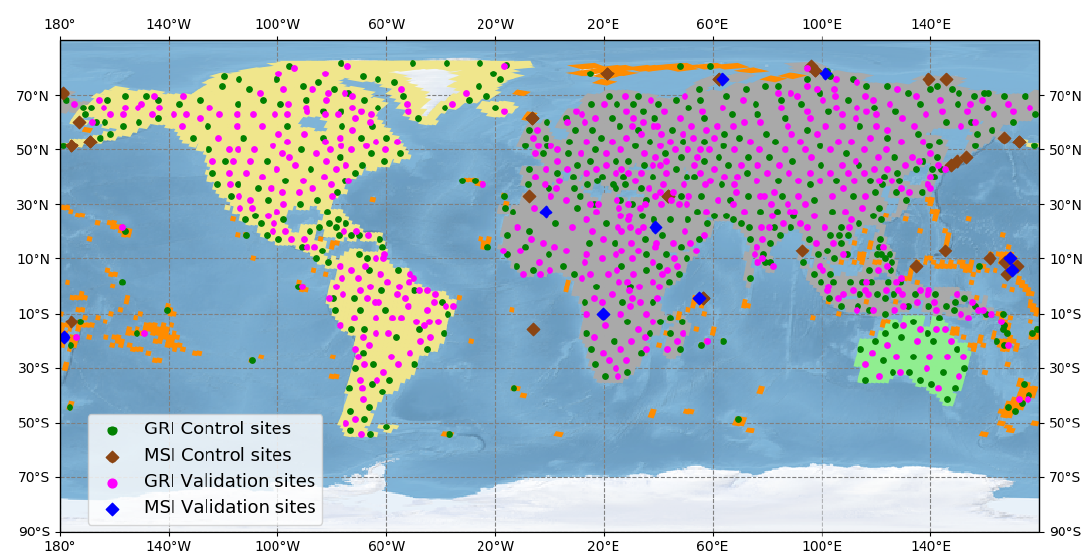
Figure 2. Control and Validation sites used in the block triangulation procedure. The green and magenta circles represent the Global Reference Image (GRI) control and validation tiles, respectively. The brown and blue diamonds represent the Multispectral Imager (MSI) control and validation tiles, respectively. Table 1. Number of Global Reference Image (GRI) control and validation tiles used in the triangulation block. Number of Block Name